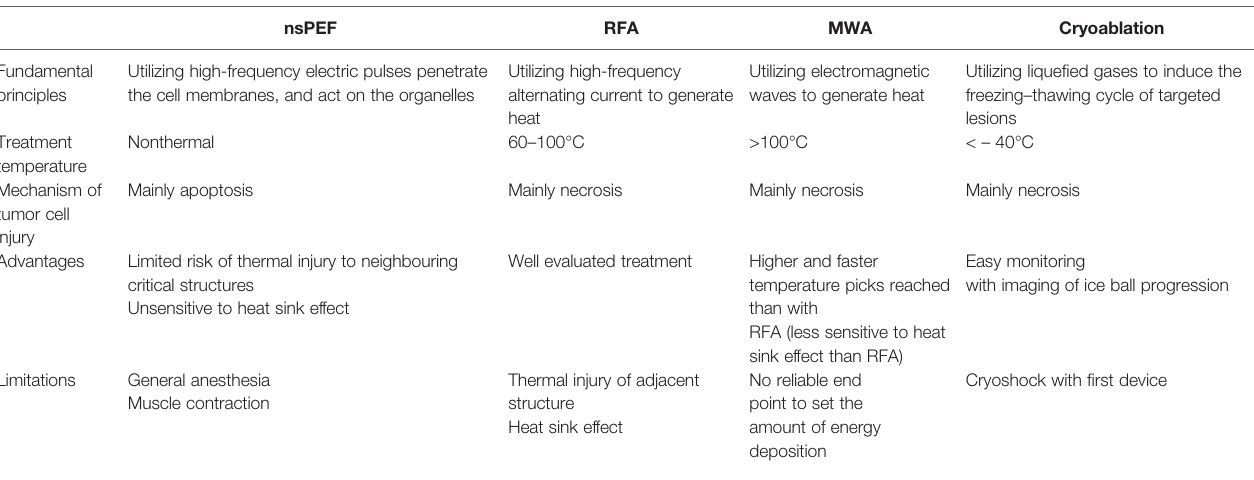
TABLE 1 | Comparison of the mechanism of nsPEF and thermal